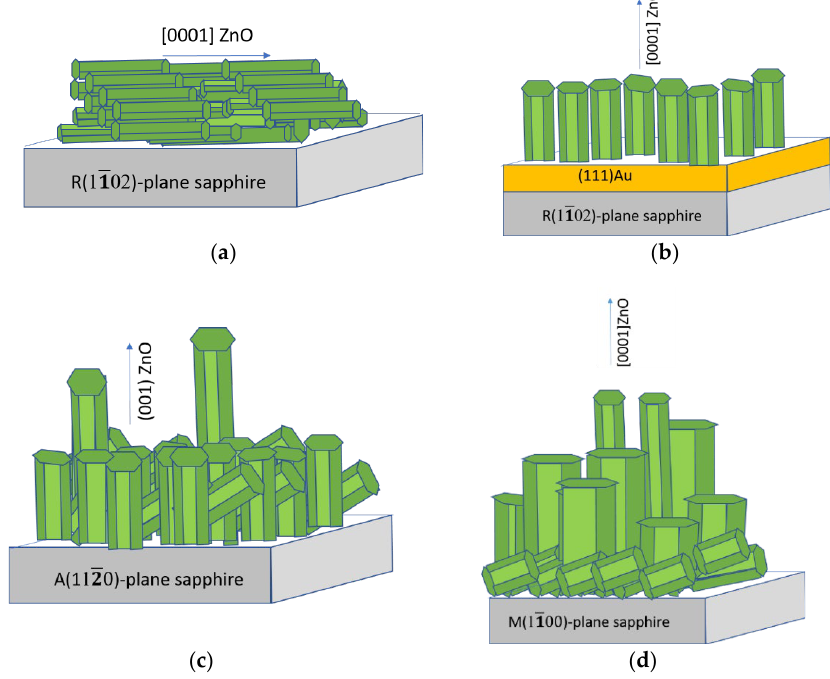
Figure 3. Proposed growth scheme for ZnO films of types R-I ( a ), R-II ( b ), A ( c ), and M ( d ). Table 2. Comparative features of surface topography, morphology, and crystal structure of the fab- ricated ZnO films.